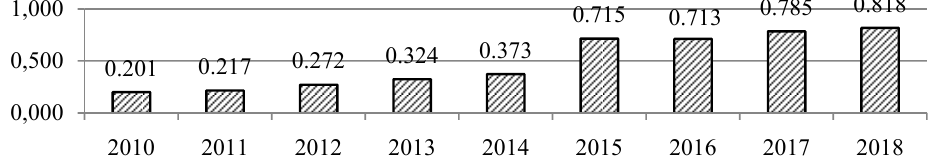
Fig. 7. Dynamics of taxonomic indicator in